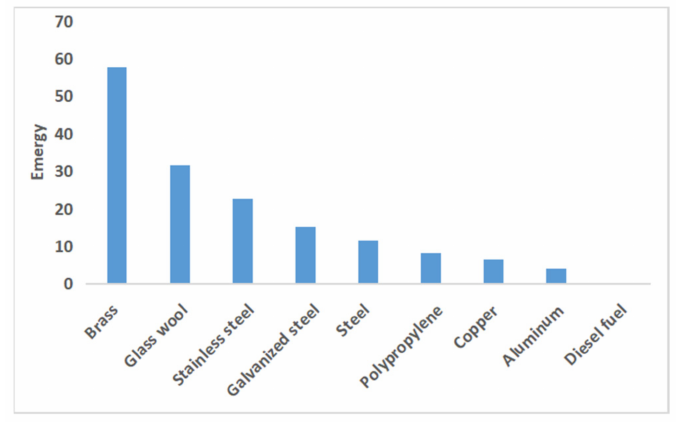
Figure 9. All inputs of heating and cooling subsystems (unit: 10 15